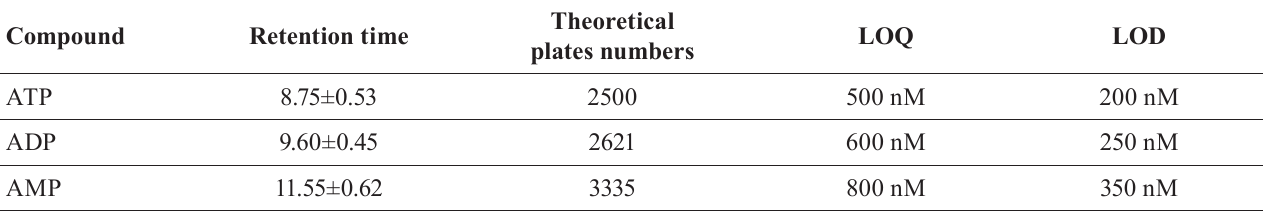
TABLE II - Important parameters of compounds